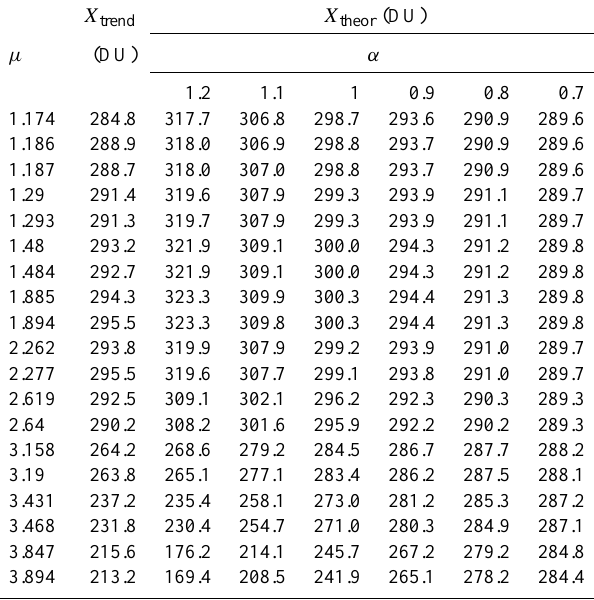
Table 2. (cid:49)X values calculated by Basher’s model for the case of 5 September 2012 for R 0 = 10 − 3 . 8 and all α values ( µ 1 = 1 . 0 and µ 2 = 2 . 5).